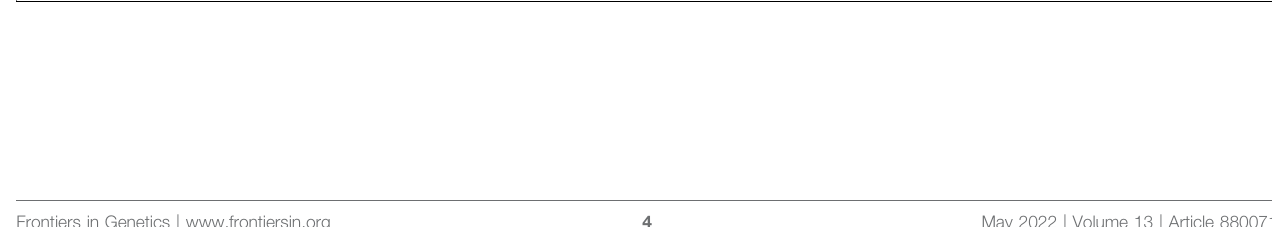
Frontiers in Genetics | www.frontiersin.org May 2022 | Volume 13 | Article 880071